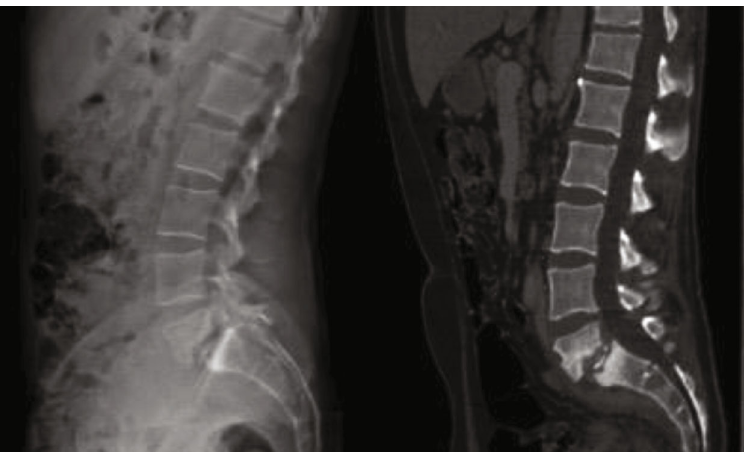
Figure 2: Preoperative (a) lumbar spine radiography in standing position and (b) lumbar CT scan, demonstrating the L5-S1 spondylodiscitis on previous spondylolisthesis, with major osteolysis of the vertebral endplates.